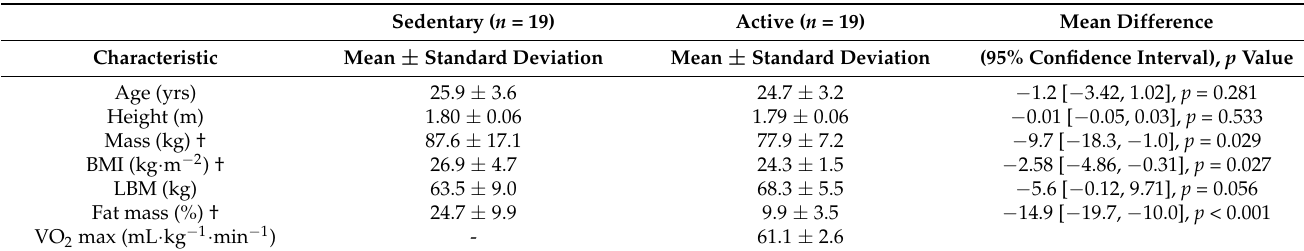
Table 1. Physical and anthropometric descriptors of study participants. Sedentary ( n = 19) Active ( n = 19) Mean Difference Characteristic Mean ± Standard Deviation Mean ± Standard